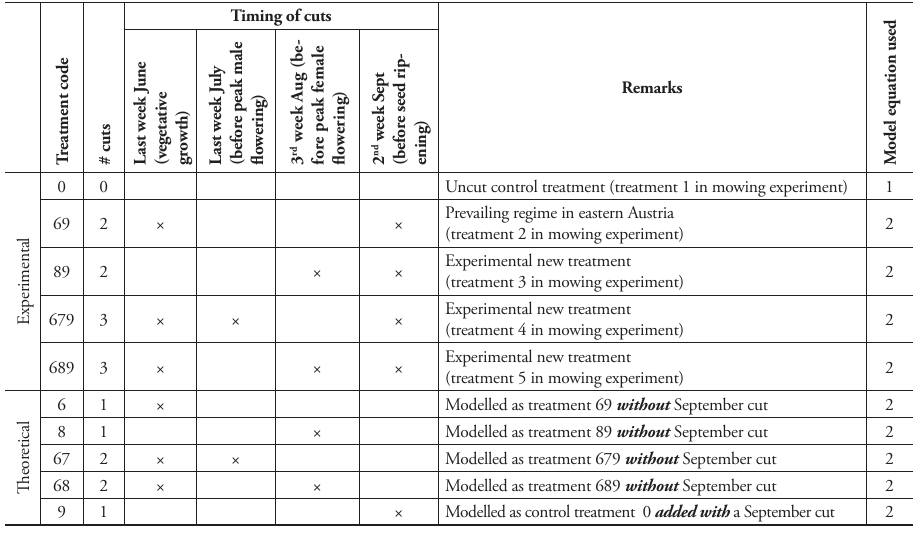
Table 1. Overview of the experimental (upper half of table) and theoretical (lower half) mowing treat- ments. Their treatment code (indicating the calendar months in which cuts were conducted), the number and timing of cuts (each × indicating a cut) are